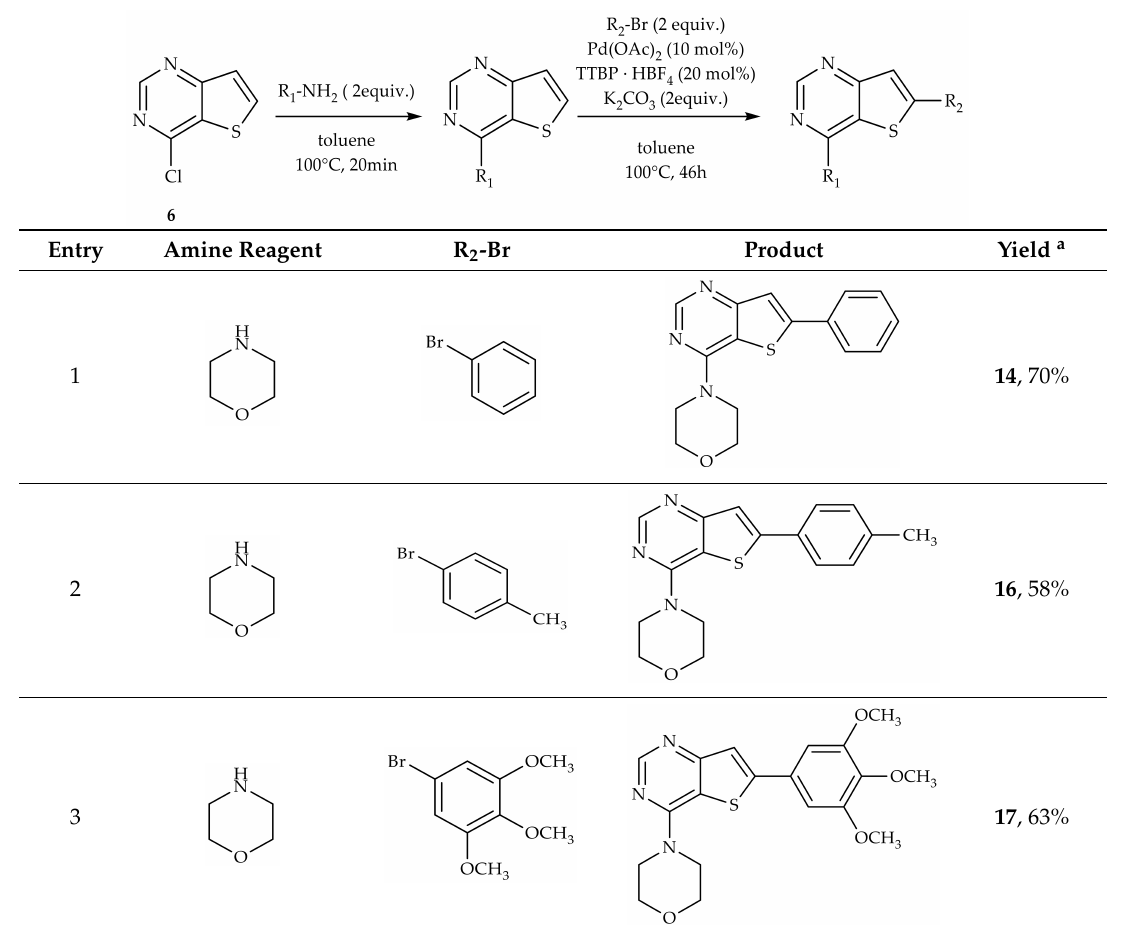
Table 4. Scope and limitations of the one pot SnAr-Pd-catalyzed direct arylation from 4-chlorothieno [3,2- d ]pyrimidine 6